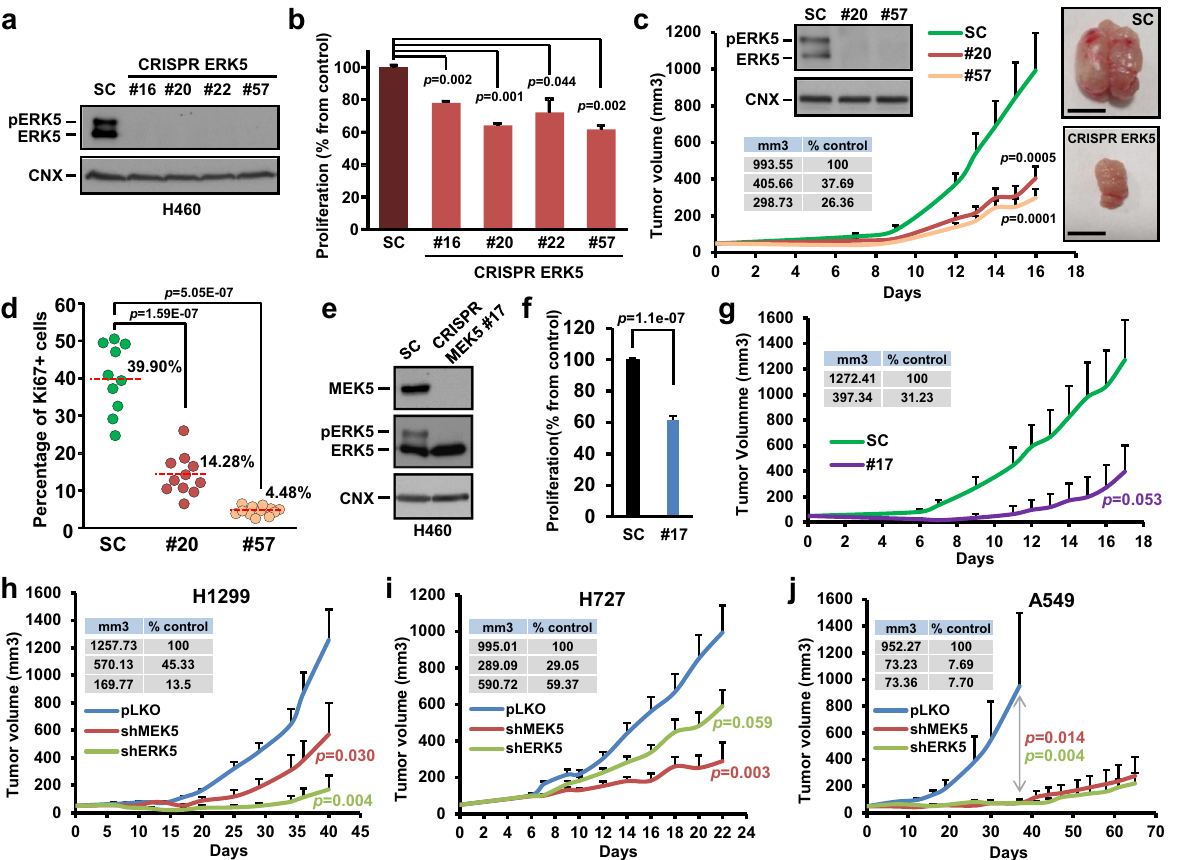
Fig. 3 Effect of ERK5 knockout on tumor growth of H460 lung cancer cells. a Western blot showing lack of ERK5 expression in the different H460 ERK5 CRISPR clones when compared to the control H460 scramble cells (SC). b 35,000 cells of H460 SC or H460 CRISPR ERK5 clones were cultured for 3 days in p6 wells and the proliferation rate was measured by cell counting. Data are represented as mean percentage from control H460 scramble cells ± SD of an experiment that was repeated three times. p -values are indicated. c Tumor growth evolution of the mice xenoinjected with H460 SC or ERK5 CRISPR cells (#20 and #57 clones) ( n = 10 tumors, per group). The mean tumor volume and SEM error bars of each group are represented. The experiment was stopped once one of the mice tumors reached a volume of 1500 mm 3 . The volume percentage of ERK5 CRISPR tumors when compared to scramble tumors, the signi fi cative p -values, and representative pictures are displayed (scale bars = 1 cm). Inset western blot showing that ERK5 expression was not recovered in the H460 ERK5 CRISPR cells after the in vivo experiment is included. d Ki67 immunostaining was quanti fi ed from 10 to 12 different pictures of scramble and ERK5 CRISPR clones and represented as percentage of Ki67 positive cells from total. The average percentage (red line) and p -value for each ERK5 CRISPR clone are indicated. e Western blot analyses of MEK5, ERK5, and pERK5 in the H460 MEK5 knockout clone #17. f In vitro and g in vivo effect of the MEK5 knockout on the proliferation and tumorigenesis of H460 cells ( n = 7 tumors per group). The procedures for evaluation of these effects were as described above for ERK5. h Effect of MEK5 or ERK5 knockdown on the in vivo tumorigenesis of H1299 cells ( n = 5 – 6 tumors per group), i H727 cells and j A549 cells ( n = 6 – 8 tumors per group). Equal number of pLKO shControl, shMEK5 (sh66) or shERK5 cells were injected subcutaneously, and tumor sizes periodically measured. The mean tumor volume, SEM error bars, and p -values between groups are indicated. Additional information is provided in the “ Methods ”